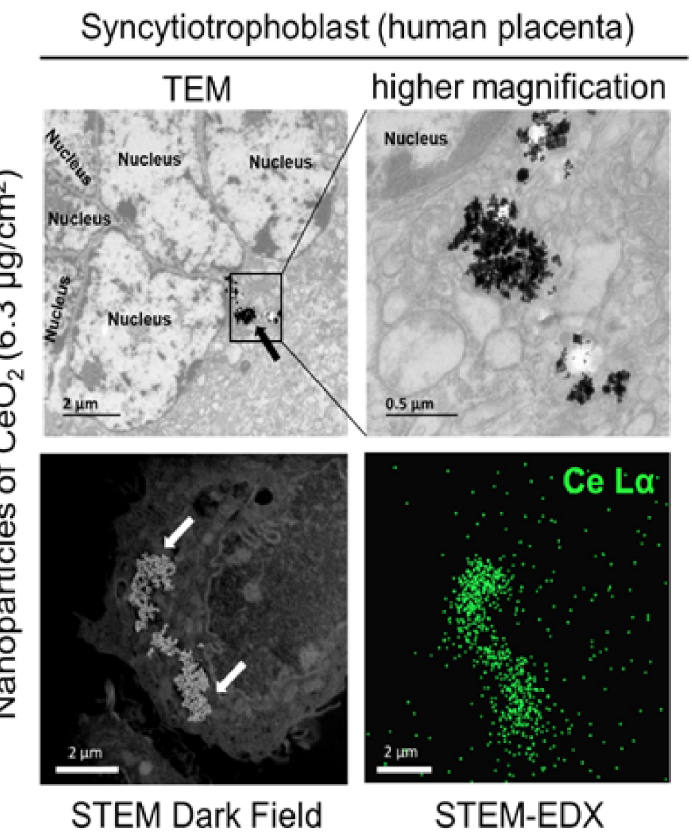
Figure 3. Impacts of nanoceria on term primary culture of human trophoblast. Primary culture of human third trimester cytotrophoblasts exposed for 72 h to CeO 2 NPs. Observation of CeO 2 NPs by transmission electron microscopy (TEM), scanning transmission electron microscopy (STEM) combined with energy dispersive X-ray spectroscopy (EDX). Magnified image of TEM is automatically rotated by around 90 ◦ to the right. Figure modified after Nedder et al.